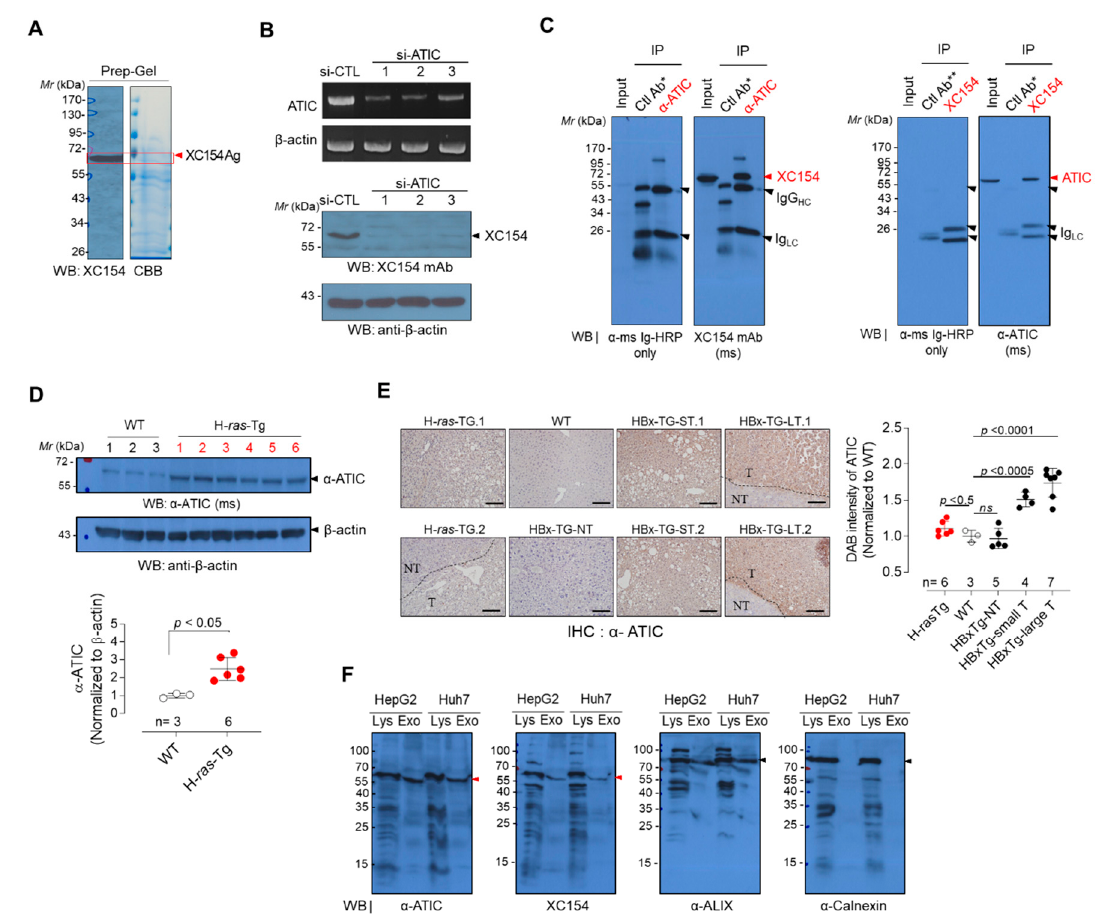
Figure 2. The target antigen of XC154 mAb was oncogenic ATIC. ( A ) Preparative 10% SDS-PAGE to isolate XC154 antigen and in-gel digestion for the mass spectrometric protein identification. The protein band containing XC154 antigen, which was confirmed by Western blotting, was excised (indicated by the red arrow) and in-gel digested. Proteins identified by mass spectrometric analysis were listed in Table 1. ( B ) The validation of XC154 antigen as ATIC. HepG2 cells were transfected with si-ATIC and their cell lysates were analyzed by Western blotting with XC154 mAb. β -Actin was used as an internal control. ( C ) Immunoprecipitation analysis for the verification of XC154 antigen as ATIC. Red arrows indicate XC154 Ag or ATIC. ( D ) The expression of ATIC in liver tissues of H- ras12V -Tg mice. Blots were probed with commercial anti-ATIC antibody. ( E ) Immunohistochemical analysis of ATIC in liver tissues of HCC model mice. Liver tissues from wild type control mice (Non-Tg: WT) were also stained. NT: non-tumor, T: tumor region, H- ras12V -Tg ( n = 6), Non-Tg ( n = 3), HBx-Tg-nonT: HBx-transgenic mouse without tumor ( n = 5), HBx-Tg-ST: HBx-transgenic mouse with small tumor ( n = 4), HBx-Tg-LT: HBx-transgenic mouse with large tumor ( n = 7). Representative images were shown (All staining images were shown in Supplementary Figure S2). ( F ) ATIC in exosomes purified from hepatoma cell cultured media (HepG2 and Huh7 cells; 35 µ g) analyzed by Western blotting. A well-known exosomal marker, ALIX, and ER marker, Calnexin, were probed as controls. The red arrow indicates